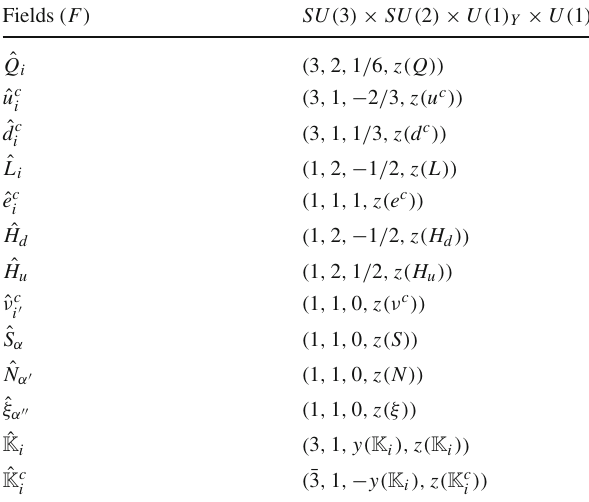
Table 1 Chiral superfields in U μν SSM models and their quantum numbers, for the solution in Eq. (6) with the presence of the extra quark singlets ˆ K i and ˆ K c , i = 1 , 2 , 3. The indexes i (cid:2) ,α,α (cid:2) and i α (cid:2)(cid:2) correspond to the number of different singlet superfields. z ( F ) denotes the U ( 1 ) (cid:2) charge of a field F . For the alternative solu- tion in Eq. (7), the last two representations must be replaced by the four representations ˆ K ( 3 , 1 , y ( K ), z ( K )) , ˆ K c ( ¯ 3 , 1 , − y ( K ), z ( K c )) , ˆ D ( 3 , 2 , y ( D ), z ( D )) and ˆ D c ( ¯ 3 , 2 , − y ( D ), z ( D c )) Fields ( F